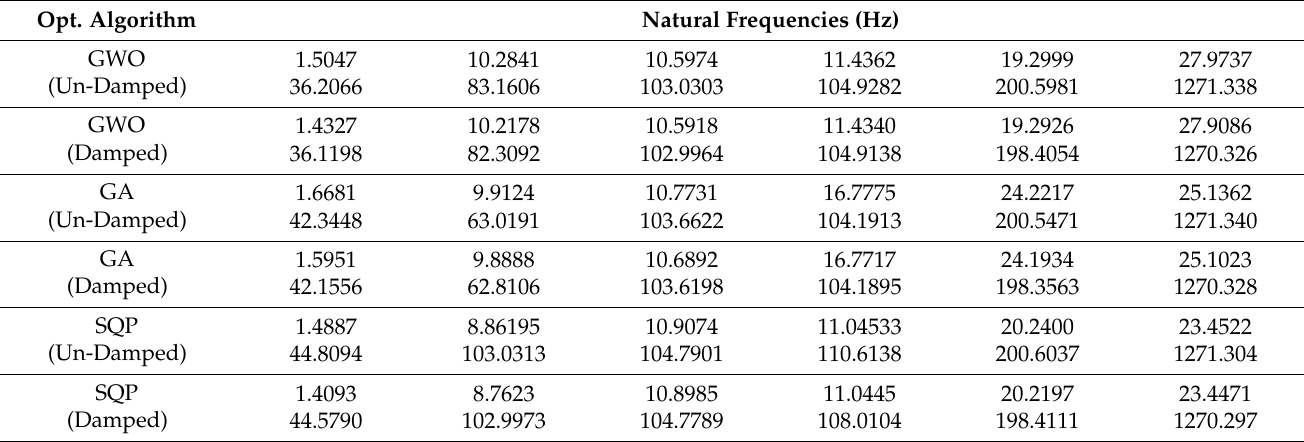
Table 4. Optimization results of natural frequencies (12-DOF model—shaking loads only).